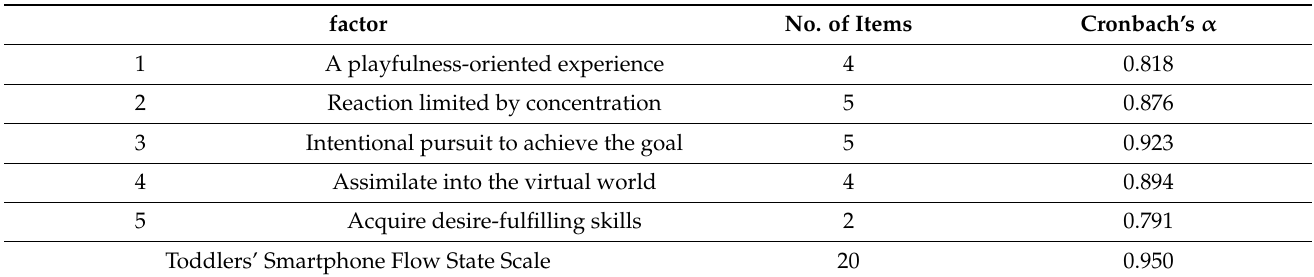
Table 8. Internal consistency reliability for